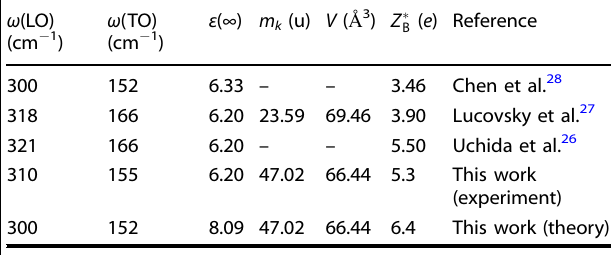
Table 2. Comparison of parameters and Born effective charge for the E u mode of 1T-HfS 2 .